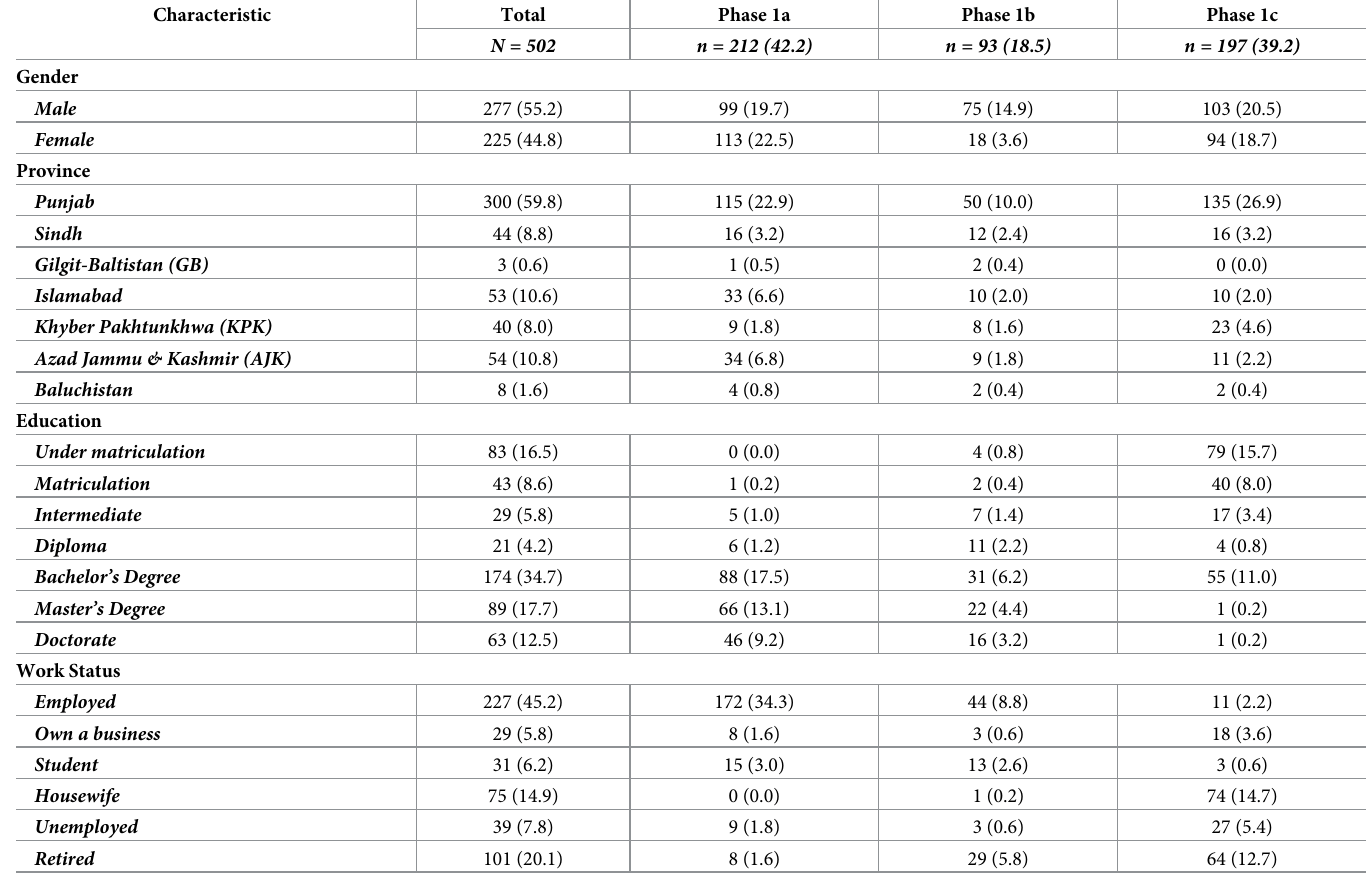
Table 1. Demographics of the